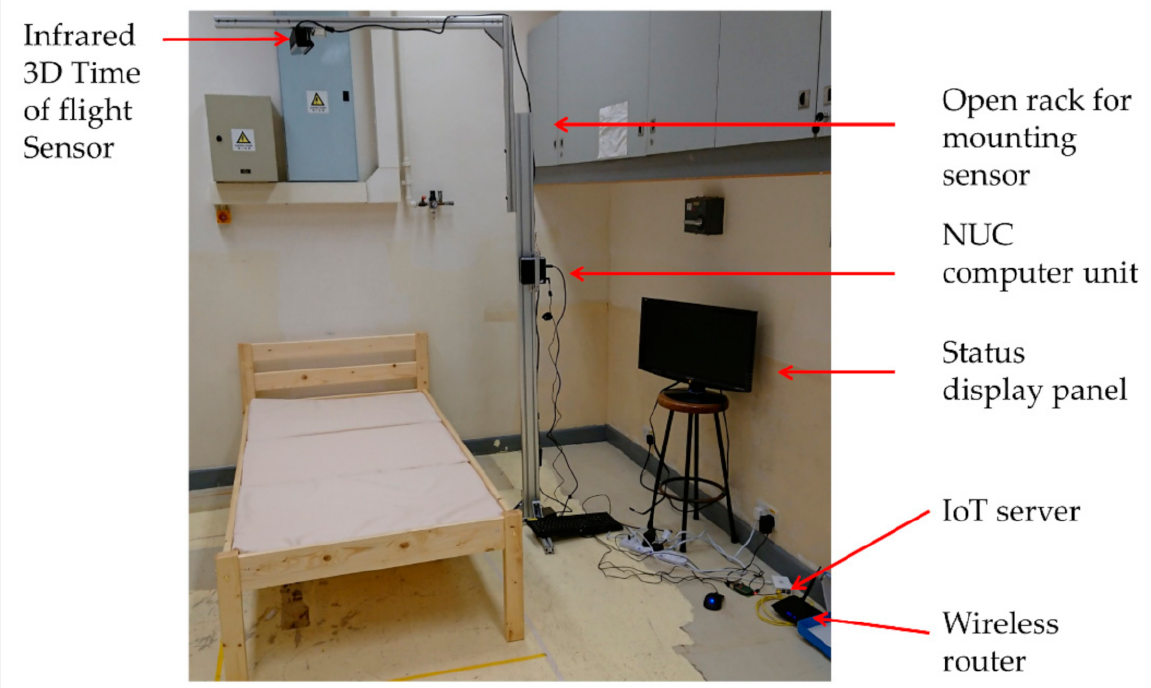
Figure 7. Simulated double bed experiment equipment